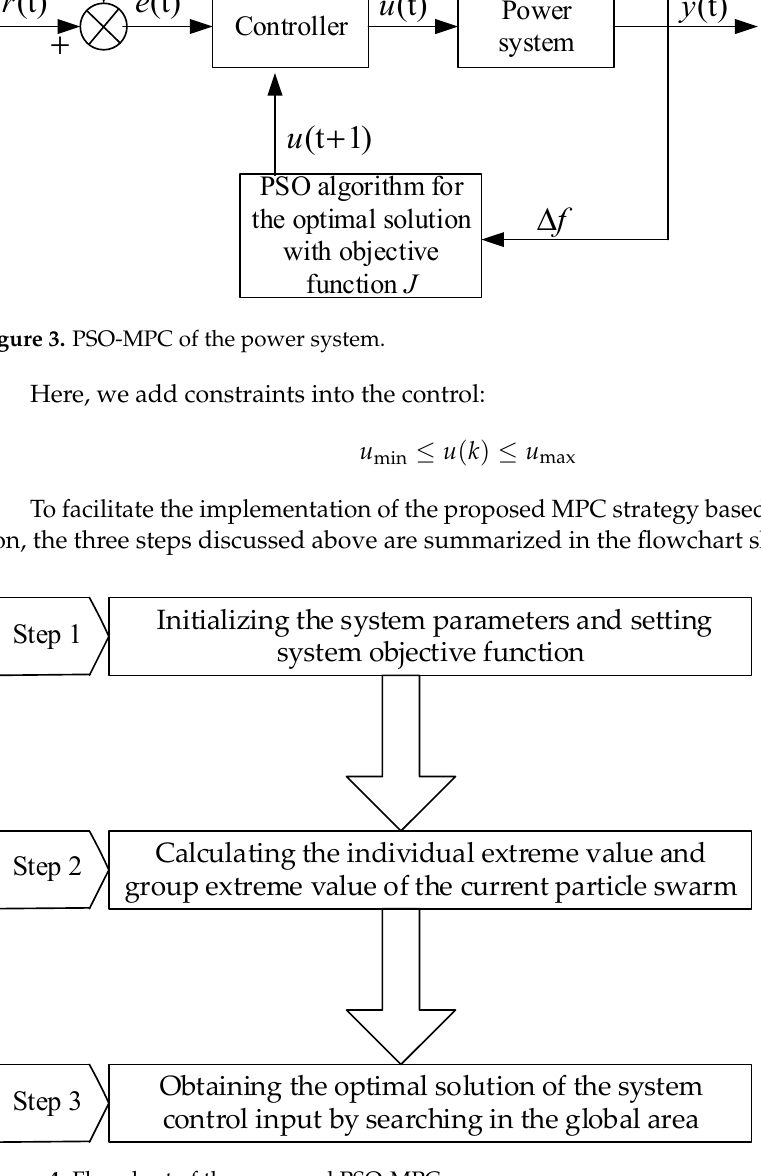
Figure 4. Flowchart of the proposed PSO-MPC.